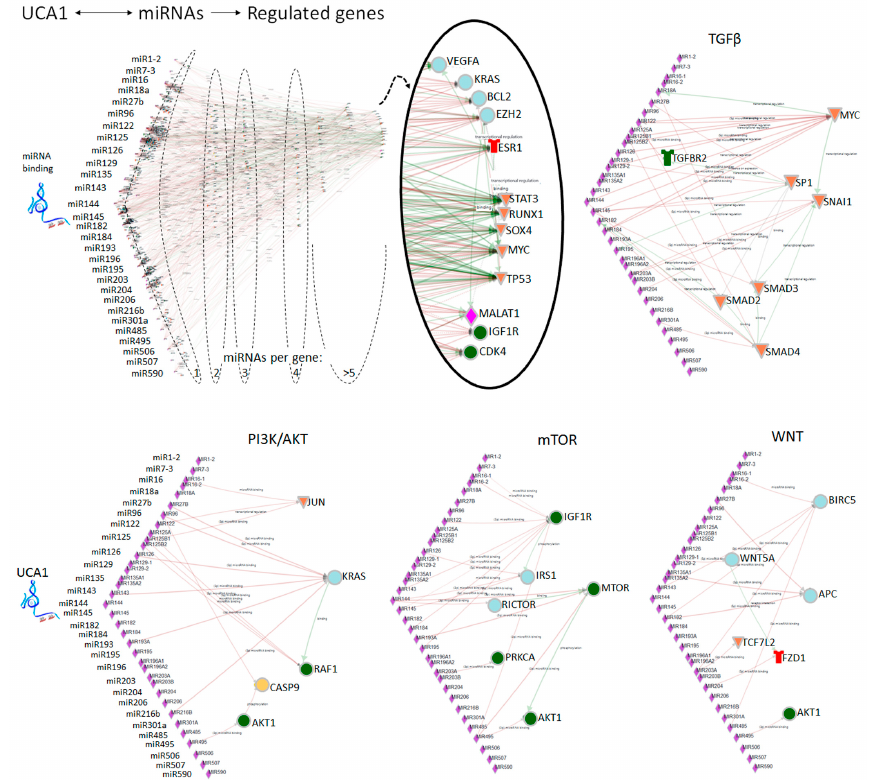
Figure 2. The regulation by Urothelial Cancer Associated 1 (UCA1)-associated miRNAs. All 29 miRNAs published to interact with UCA1 (Table 4) were submitted to the miRNA network analysis tool ONCO.IO and the downstream-regulated genes are visualized (https://onco.io/main.php). In the overall UCA1/miRNA image, genes were sorted based on the number of miRNAs bound per gene. The genes associated with over 5 miRNAs (circled) include VEGF, KRAS, BCL2, EZH2, receptor ESR1; transcription factors: STAT3, RUNX, SOX4, MYC, TP53; lncRNA MALAT; and the kinases IGF1R and CDK4. Genes that were associated with the indicated signaling pathways are also represented in individual images.